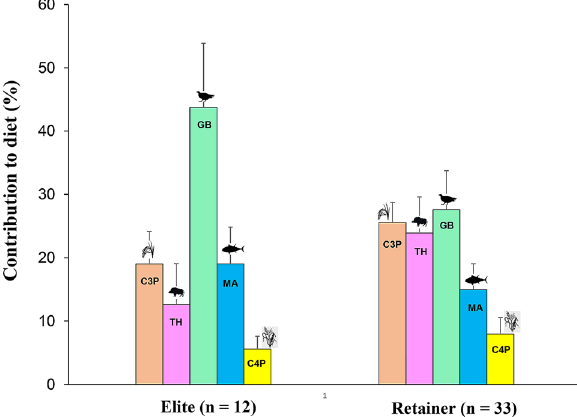
Figure 5. A bar chart representation of the proportional contribution of the five food groups (C 3 plants, terrestrial herbivores, game birds, marine animals, C 4 plants) to the Imdang humans. Elites show a higher contribution of game birds (GB) and marine animals (MA), while retainers have a higher contribution of terrestrial herbivores (TH), C 3 plants (C3P), and C 4 plants